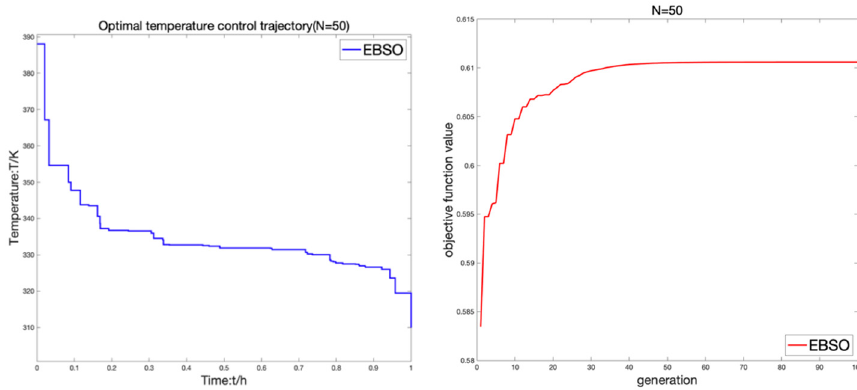
Figure 26. Optimal temperature control trajectory and iteration curve ( N = 50).